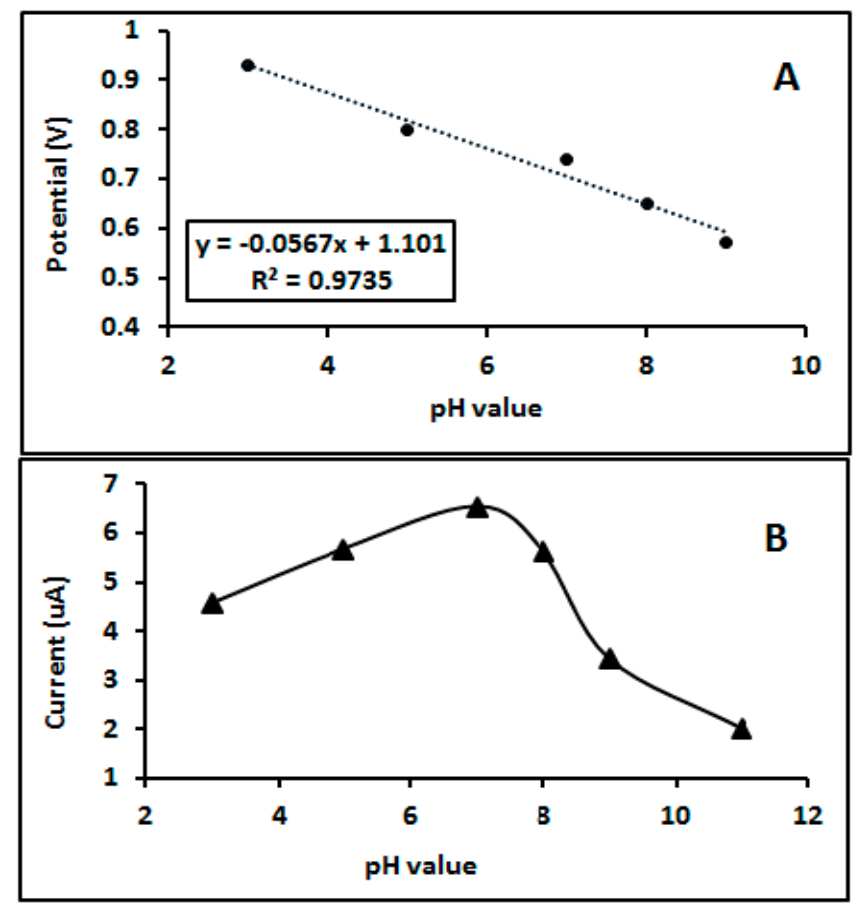
Figure 3. ( A ) Influence of pH on Potential peak; ( B ) influence of pH on current response; of 50 μ M CFN in 0.1 M BR buffer on a bare GC electrode.